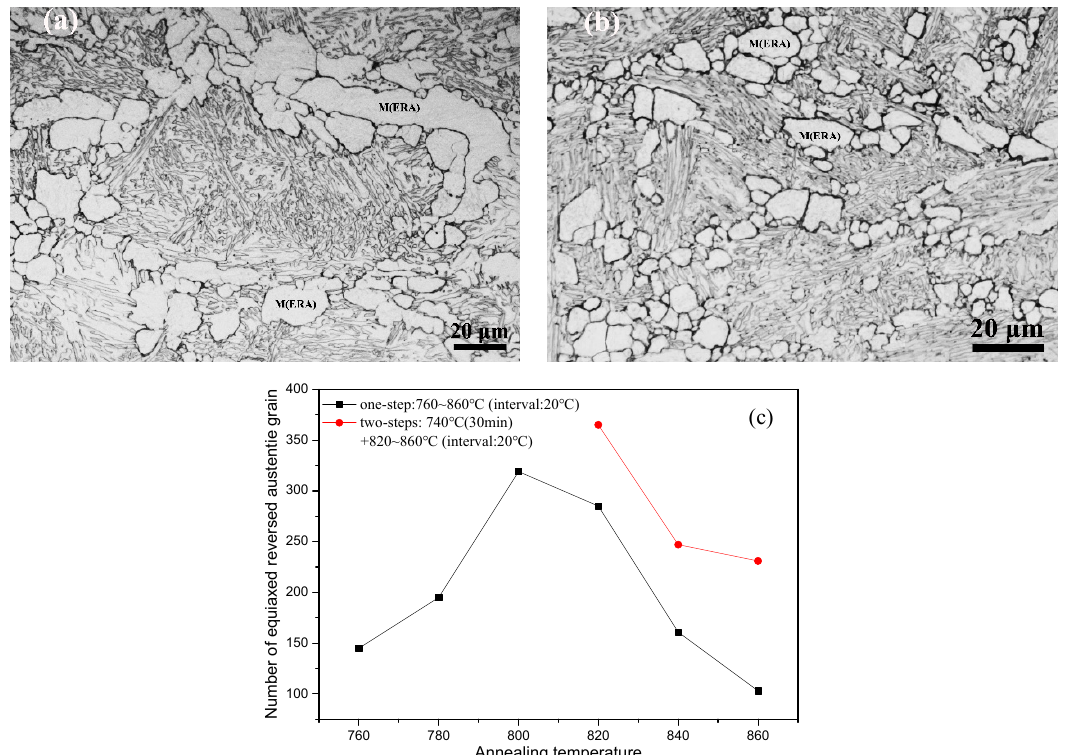
Figure 7. The optical microscope images of one-step ( a ) and two-step ( b ) at 820 °C holding 1 min; ( c ) the number of statistically equiaxed reversed austenite grain (within the size of 165 × 114 square micro meter).